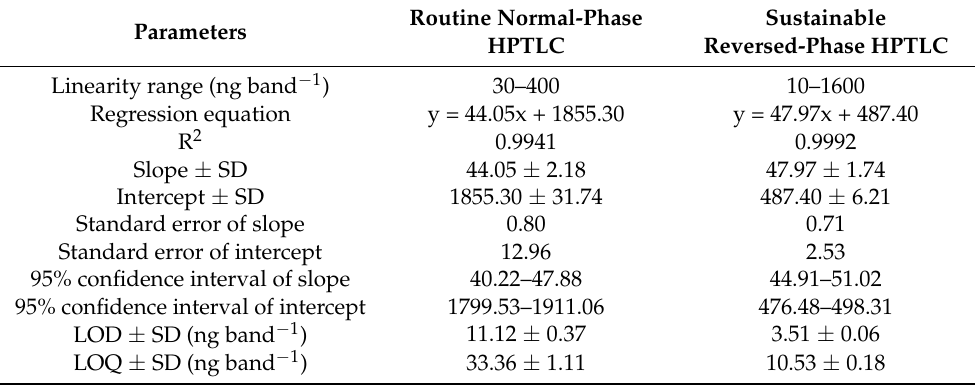
Table 1. Results for least square regression analysis of pterostilbene (PT) for the routine normal-phase high-performance thin-layer chromatography (HPTLC) and the sustainable reversed-phase HPTLC techniques (mean ± SD; n = 6).